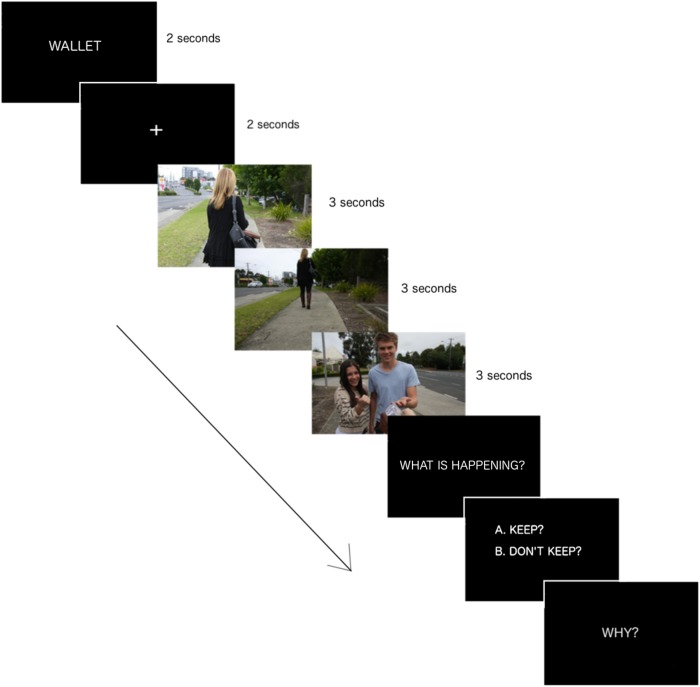
Item from the SoMoral task. The introductory screen presents the name of the dilemma. A fixation cross is then presented for 2 s. A social situation involving a moral dilemma is then presented via three first-person perspective pictures (e.g., A woman is walking and her wallet is about to fall out of her handbag (picture 1); the wallet falls out on the sidewalk while the woman continues on her way (picture 2); the participant finds the wallet and his/her friends are happy to see the money suggesting they should keep it (picture 3). The following screens present the moral understanding question, then a dichotomous decision choice and in the final screen participants are then asked to provide a justification for their decision, which is recorded verbatim for subsequent coding.